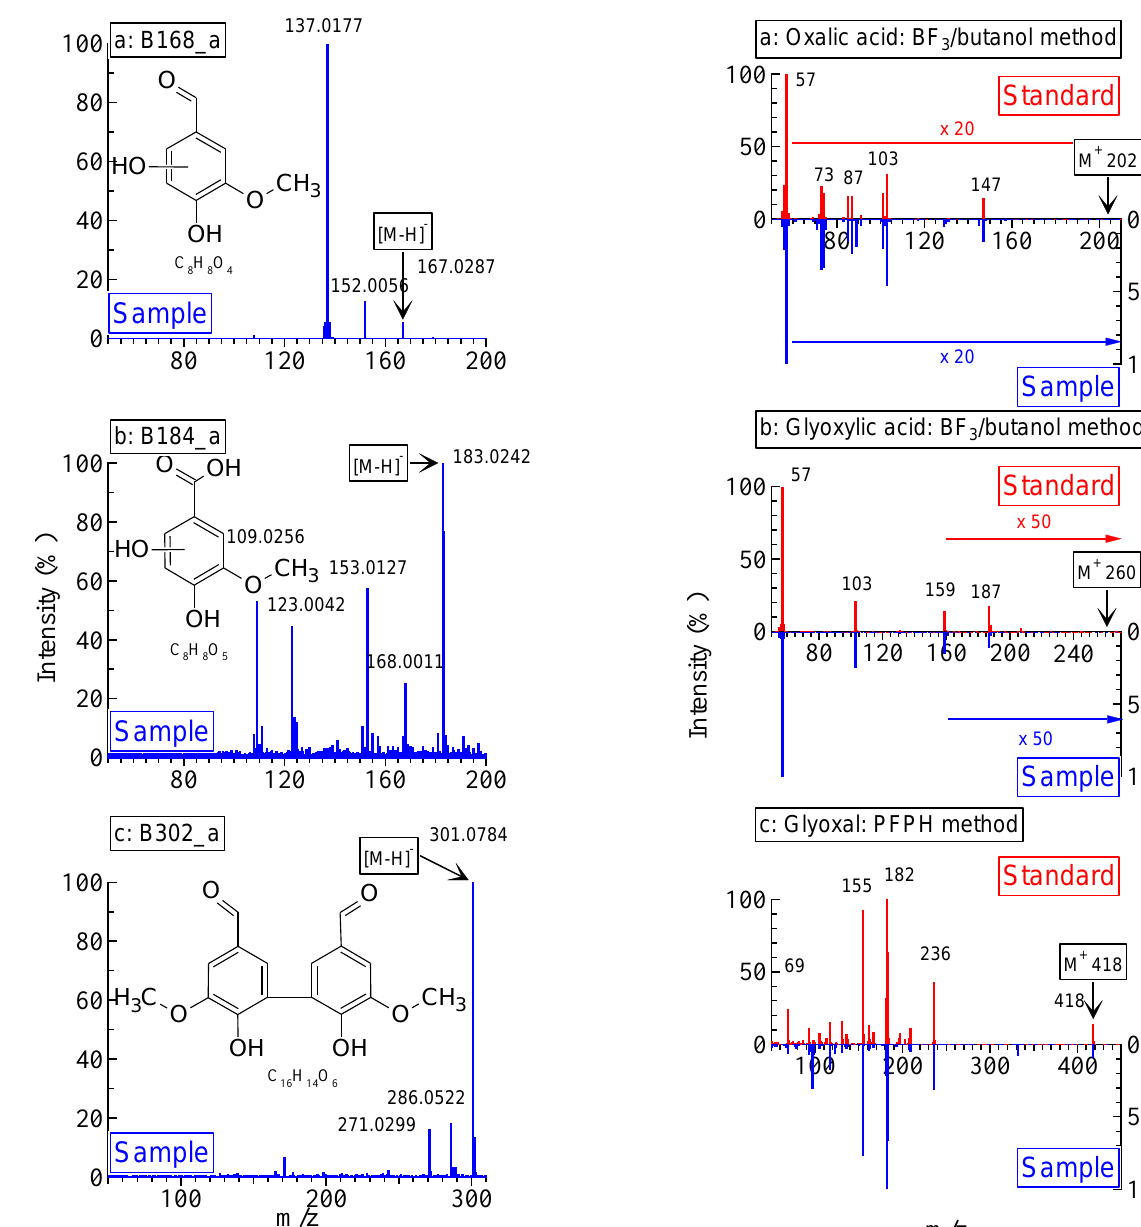
Fig. 6. Mass spectra of derivatized standard compounds (shown in Figure 6. Mass spectra of derivatized standard compounds (shown in red) and mass spectra of 2 red) and mass spectra of derivatized samples (shown in blue) that contained small oxygenates obtained by GC-MS. Mass spectra of derivatized samples (shown in blue) that contained those low-molecular-weight products by GC-MS. 3 other low-molecular-weight products can be found in Fig. S13 in Mass spectra of other low-molecular-weight products can be found in Figure S13 in the Supporting 4 the